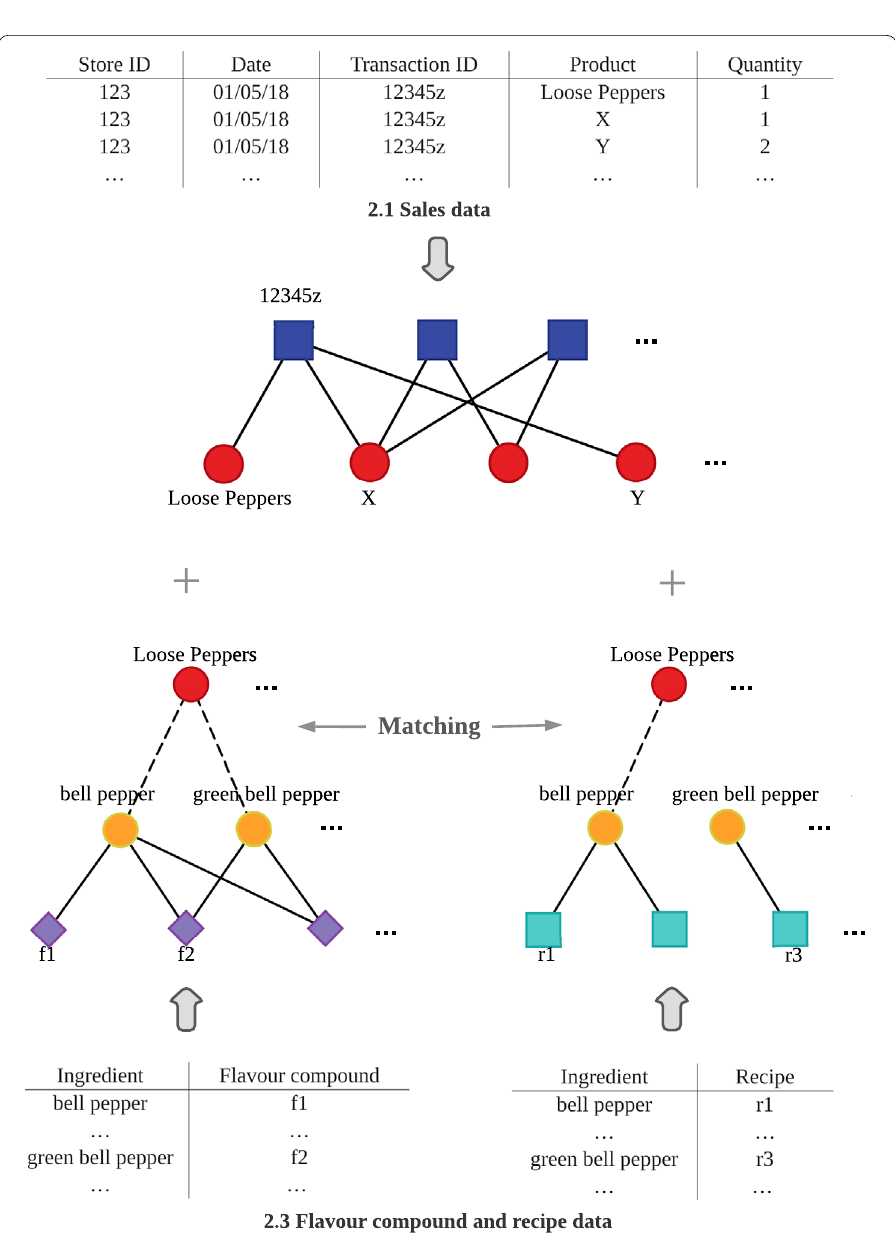
Figure 1 Schematic diagram showing the data structure of the sales data in Sect. 2.1 and the flavour compound and recipe data in Sect. 2.3, and their corresponding bipartite networks, together with the matching between the products and the ingredients, where the “Matching” step is required because of the different names that can appear in different datasets